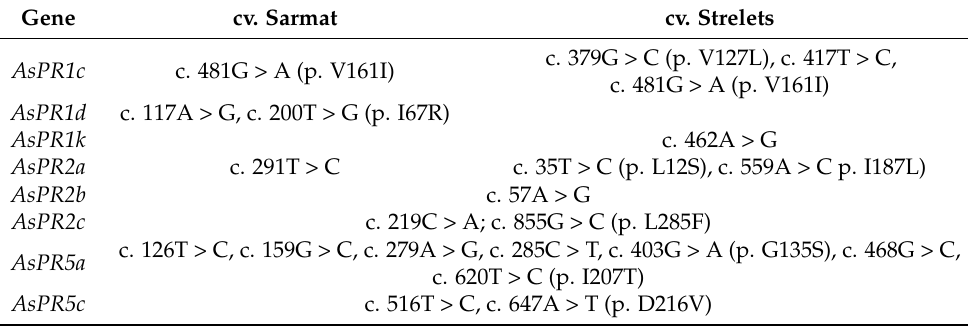
Table 4. Polymorphisms in the AsPR CDS in cv. Sarmat and Strelets compared to cv.